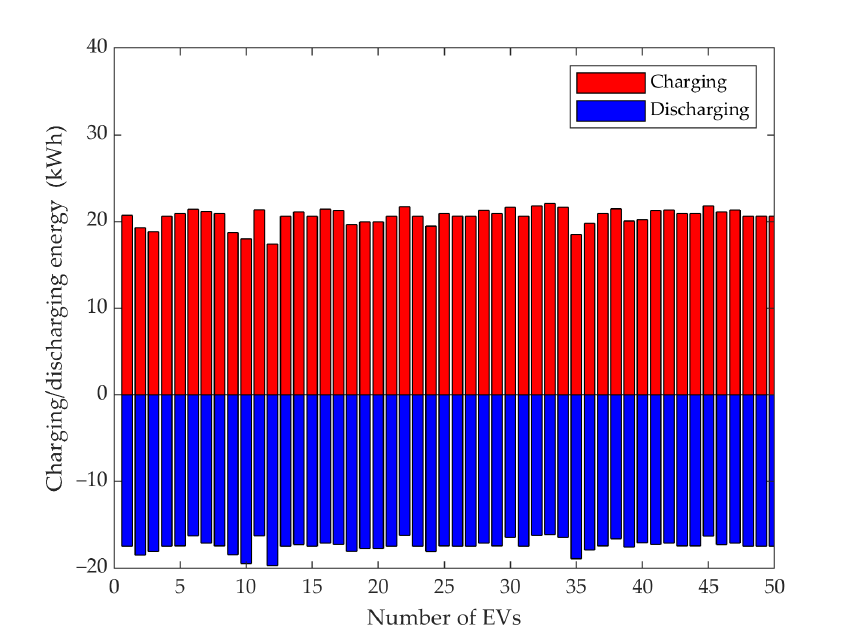
Figure 8. Individual EV charging and discharging energy from t 1 on the first day to t 1 on the second day. The EV charging cost was USD 158.08. The obtained rewards from V2G participation were USD 261.8. Although, the degradation cost was not incorporated into the objective function, we still calculated the degradation cost, which was USD 51.12. The revenue was then calculated as Reward − ChargingCost − DegradationCost = USD